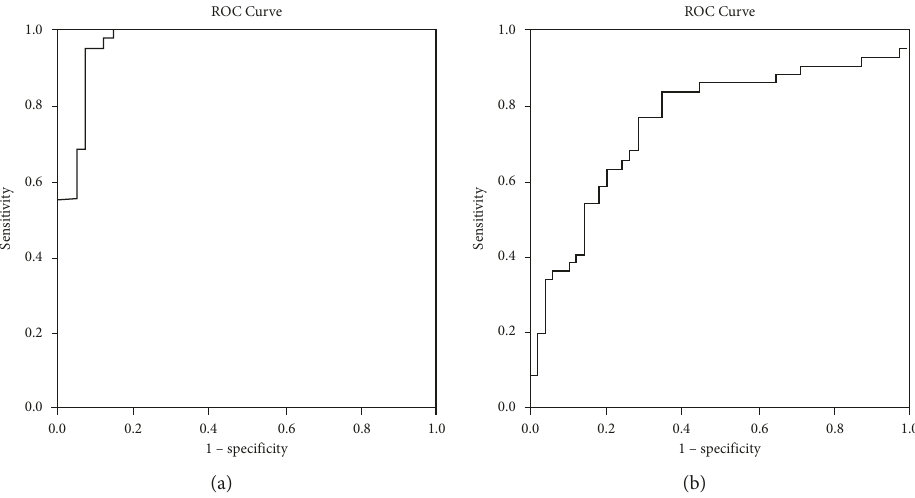
Figure 2: (a) Area under the ROC curve corresponding to the Spectralis LDF, using only retinal parameters, for diagnosis of FM. (b) Area under the ROC curve corresponding to the Triton LDF, for the diagnosis of